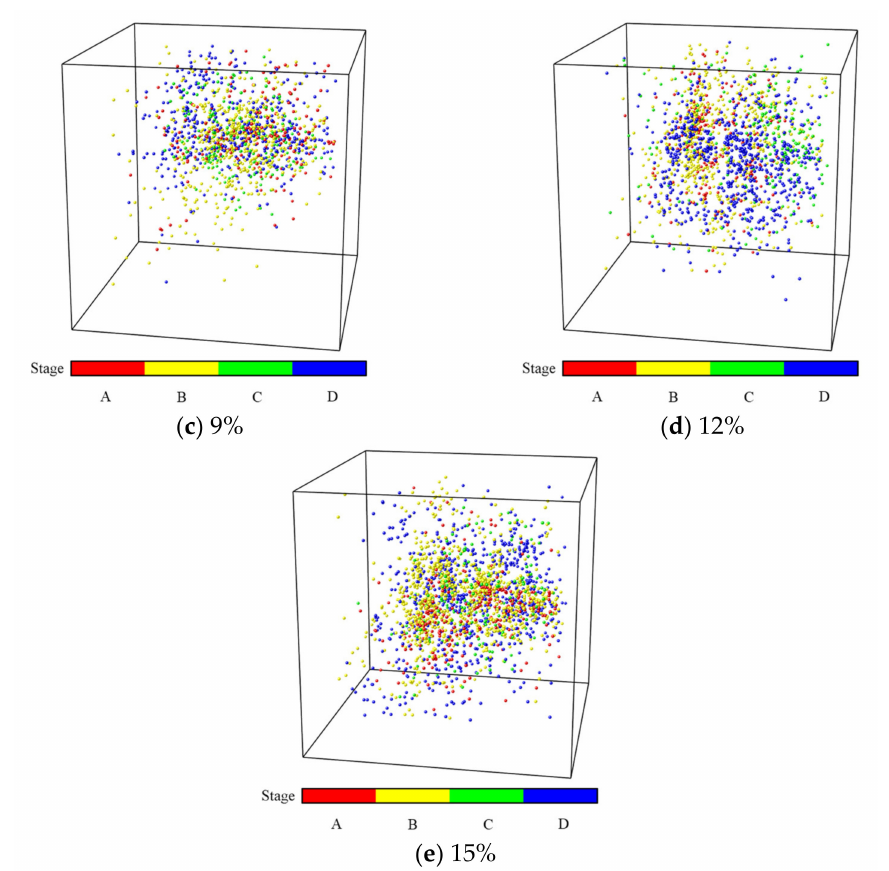
Figure 12. Acoustic emission damage location diagram of samples with different expansive agent content (quartz sand 10%) in different failure stages